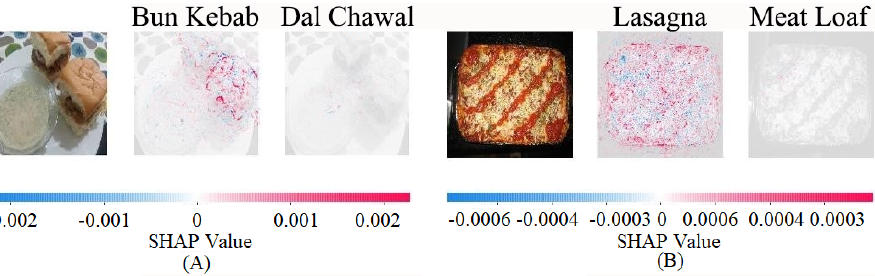
Figure 15. ( A ) Randomly selected image from Pakistani food dataset ( B ) Randomly selected image from UECFOOD256 dataset. Red pixels present the SHAP values of the image having a positive contribution towards the class while blue pixels show the pixels that reduce the probability of